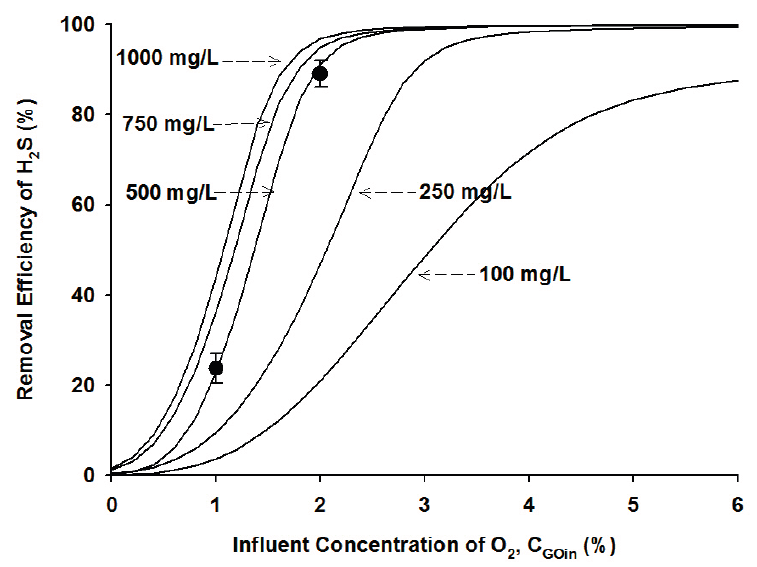
Figure 4. Experimental data (symbols) and model simulation results (lines) at different microbial densities as a function of the influent oxygen